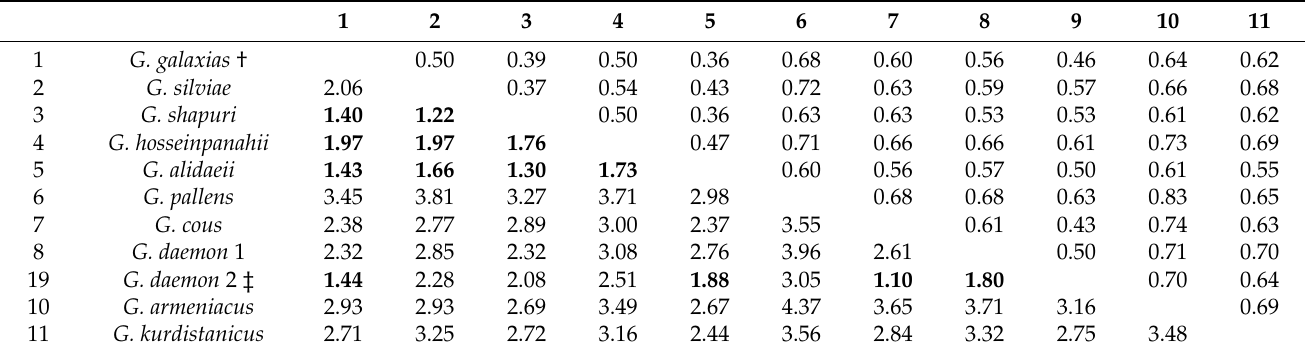
Table 2. Estimates of K2P genetic divergence (%) between different species of Glyptothorax from the Middle East (lower left matrix). Values lower than 2% are shown in bold. Standard deviations (SDs) are shown above the